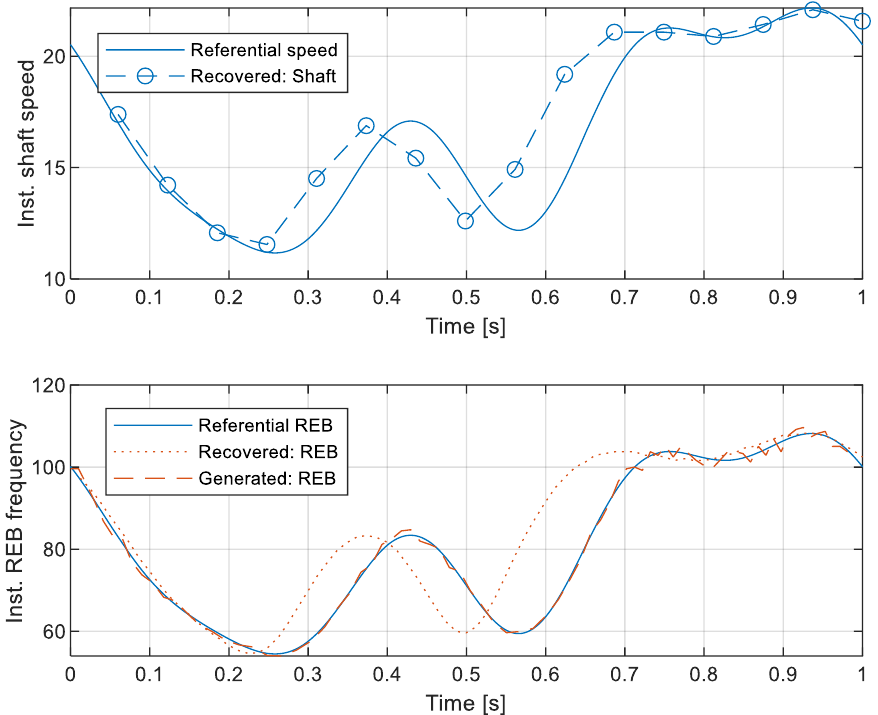
Figure 19. Comparison of different PM signals.